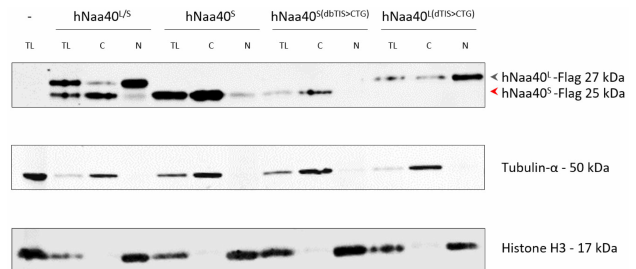
Figure 6. Differential subcellular localization of hNaa40p proteoforms. A-431 cells were transiently transfected with various C-terminally Flag-tagged hNaa40p expressing constructs encoding either both hNaa40p (hNaa40 L/S ), or solely the long (hNaa40 L(dTIS>CTG) ) or short (hNaa40 S(dbTIS>CTG) and hNaa40 S ) hNaa40p proteoform(s). Subcellular fractions enriched for nuclear (N) and cytoplasmic (C) proteins as well as total protein lysates (TL) were immunoblotted with antibodies specific for Flag, Tubulin- α and Histone H3, the latter two proteins serving as cytoplasmic and nuclear markers,